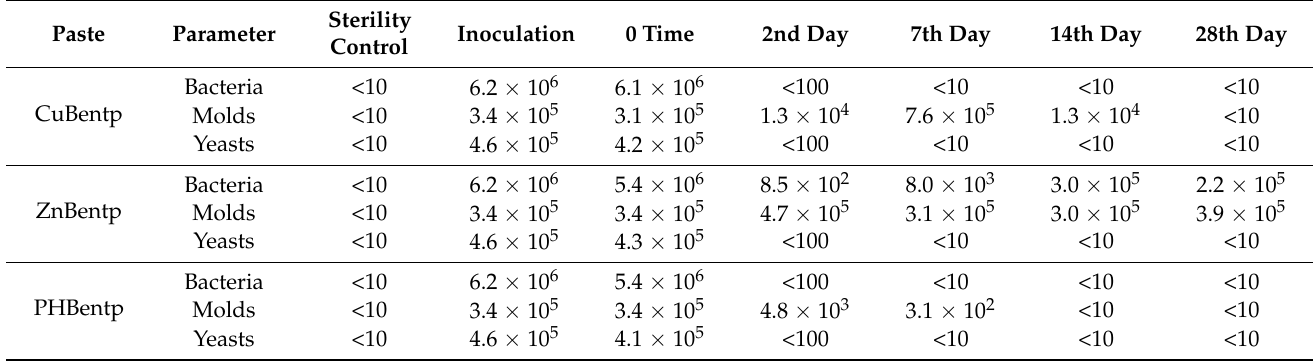
Table 7. Criteria of acceptance. (Evaluation Criteria).